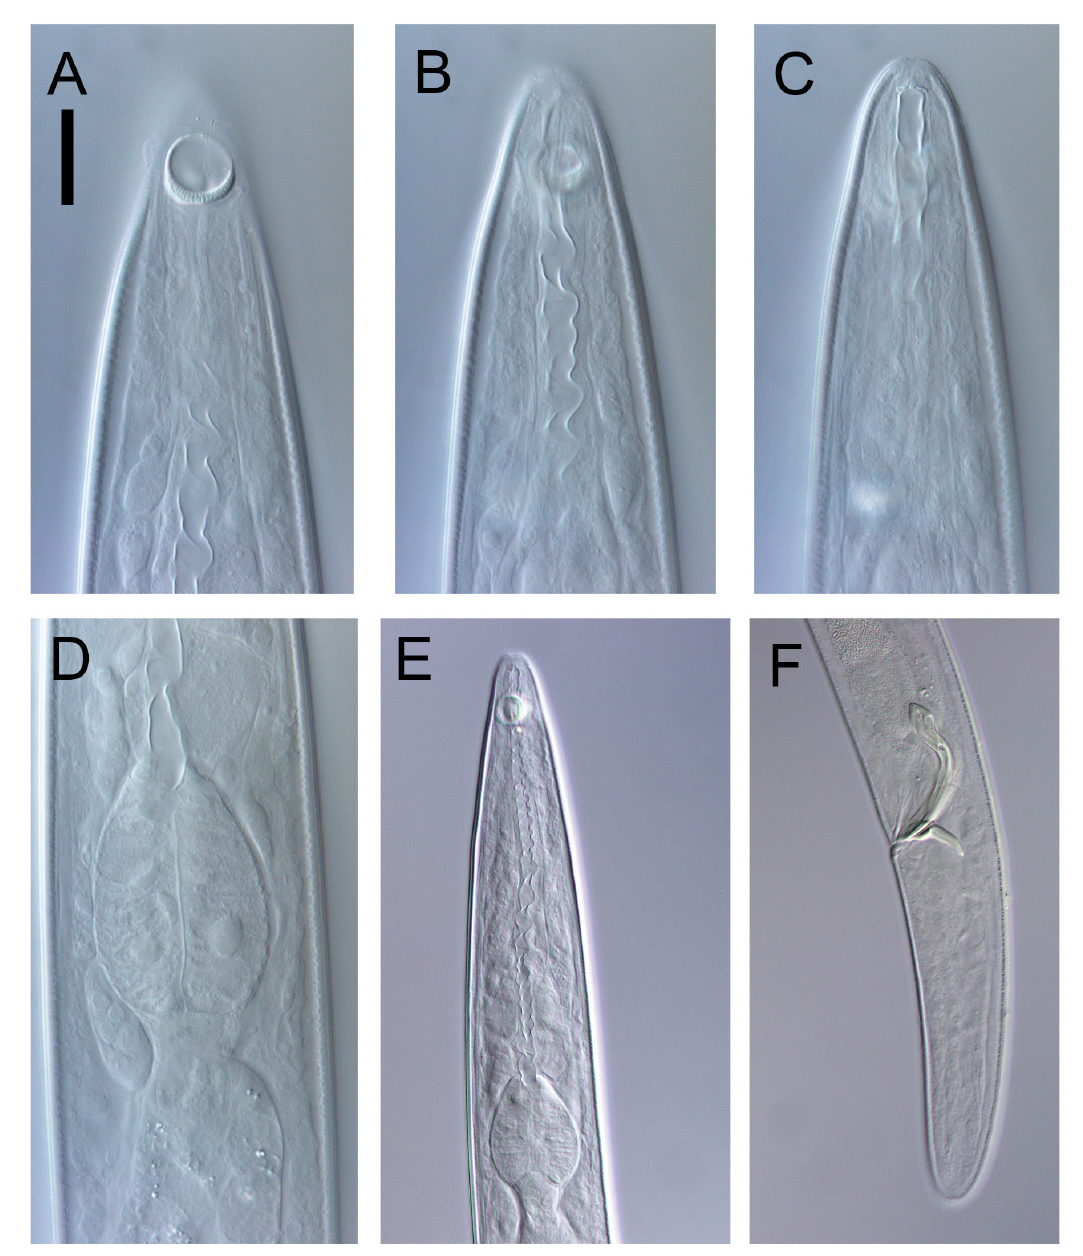
Fig. 15. Aegialoalaimus magnus sp. nov. Light micrographs. A – D . Paratype (NIWA154920). E – F . Holo- type (NIWA154918). A . Anterior portion of female showing amphid. B . Anterior portion of female showing cephalic sensilla and buccal cavity. C . Anterior portion of female showing buccal cavity. D . Junction of pharynx and intestine. E . Anterior body portion of male. F . Posterior body portion of male. Scale bar: A–D = 20 µm; E = 44 µm; F = 50